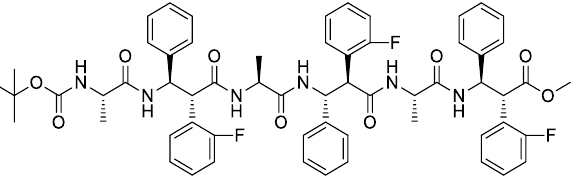
Figure 2. Chemical structure of the NH -Boc-( S -Ala-β-2 R ,3 R -Fpg) 3 -OMe α,β-foldamer 1 .